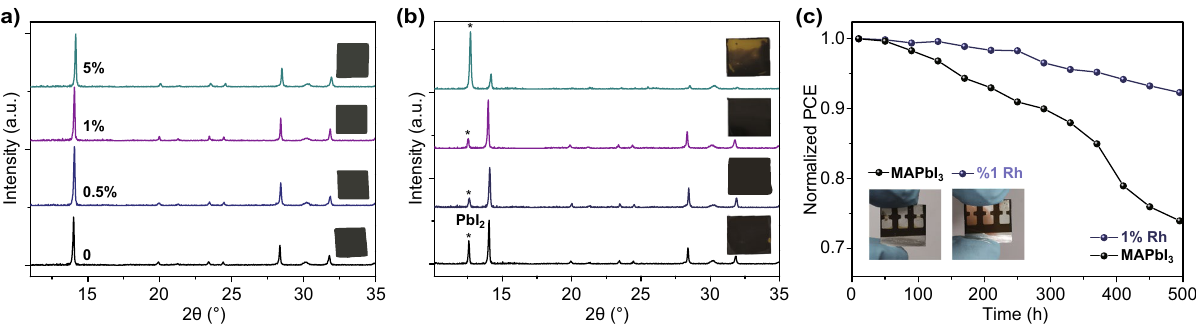
Fig. 5 a , b XRD of perovskite films based on MAPbI 3 and 1% Rh 3+ ‑incorporated is exposed in the air before and after two months. c PCE changes of perovskite solar cells located in dry air without encapsulation for 500